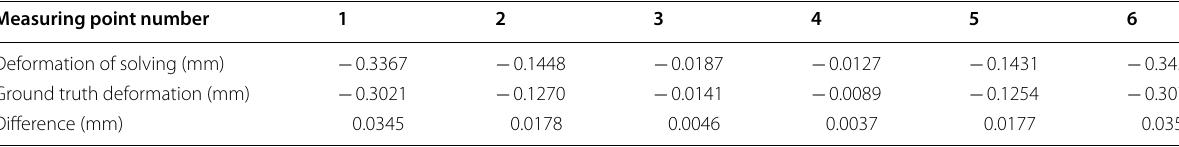
Table 3 The solved deformation values and error compared with ground truth for milling depth of 8 mm Measuring point number 1 2 Deformation of solving